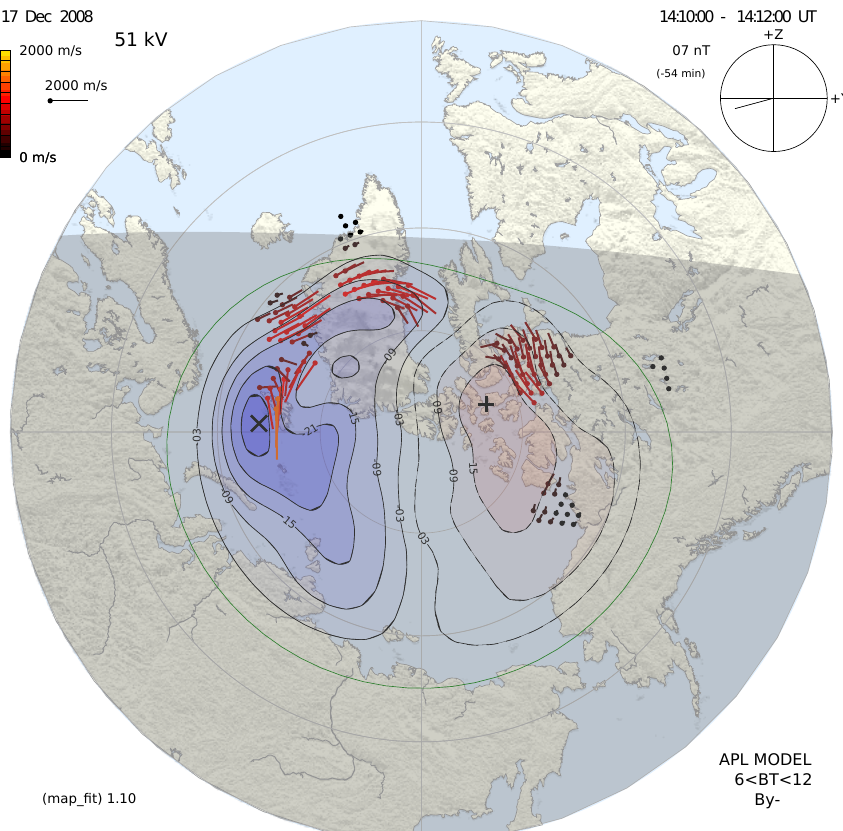
Fig. 11. SuperDARN spatial convection (ion drift) plot for 14:10–14:12UT. A channel of enhanced antisunward convection (FC 2 of type NH-dusk/ B y < 0) is seen at dusk, in the Svalbard sector. The coordinate system is MLT/MLAT.